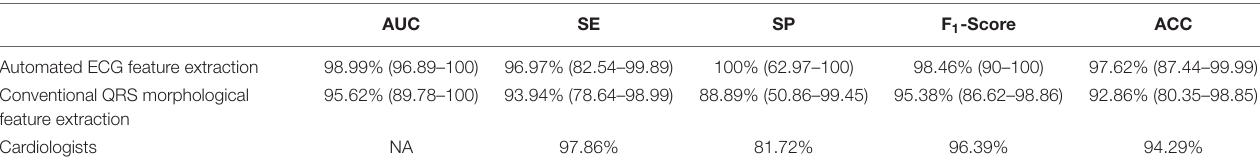
TABLE 2 | Classification performance comparison with 95%